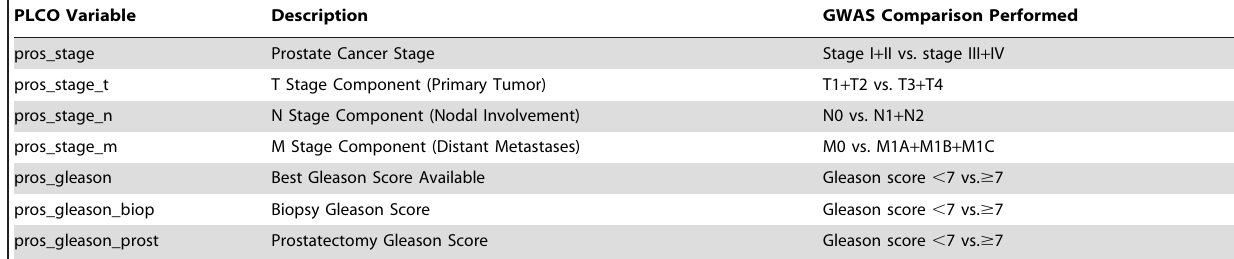
Table 4. Clinical variables analyzed in CGEMS